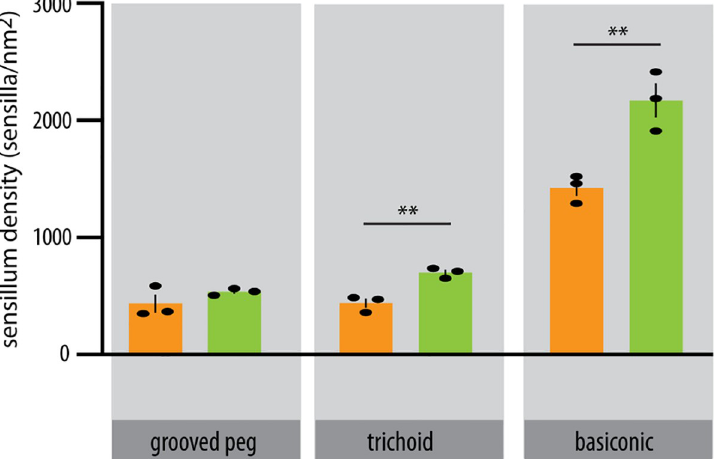
Fig 2. Sensillum density in Rhodnius prolixus and Rhodnius brethesi . Density of olfactory sensilla in flagellomere II for each species estimated as the total number of sensilla for each type, by the flagellar surface area, n = 3, unpaired t test: �� p < 0.01. Data represents mean ± SEM.